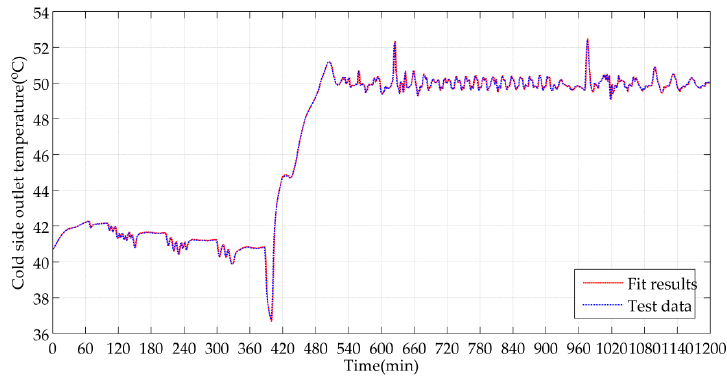
Figure 5. Fit results of cold side outlet temperature by grey-box method.